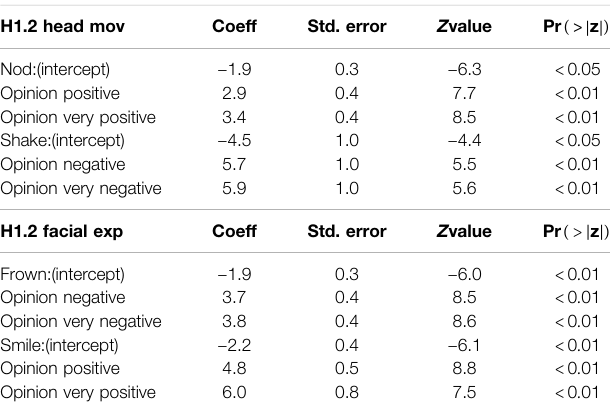
TABLE 3 | Multinomial Logistic Regression signi fi cance